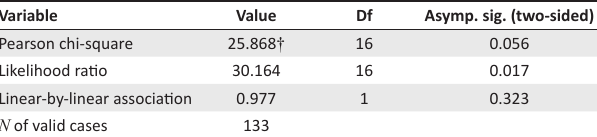
Table 3b: Chi-square tests.